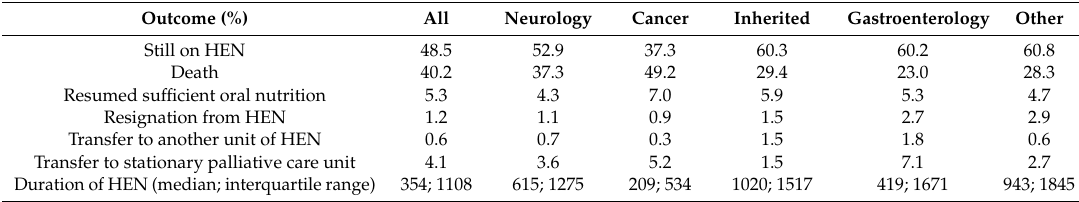
Table 5. Outcomes and median duration of home enteral nutrition